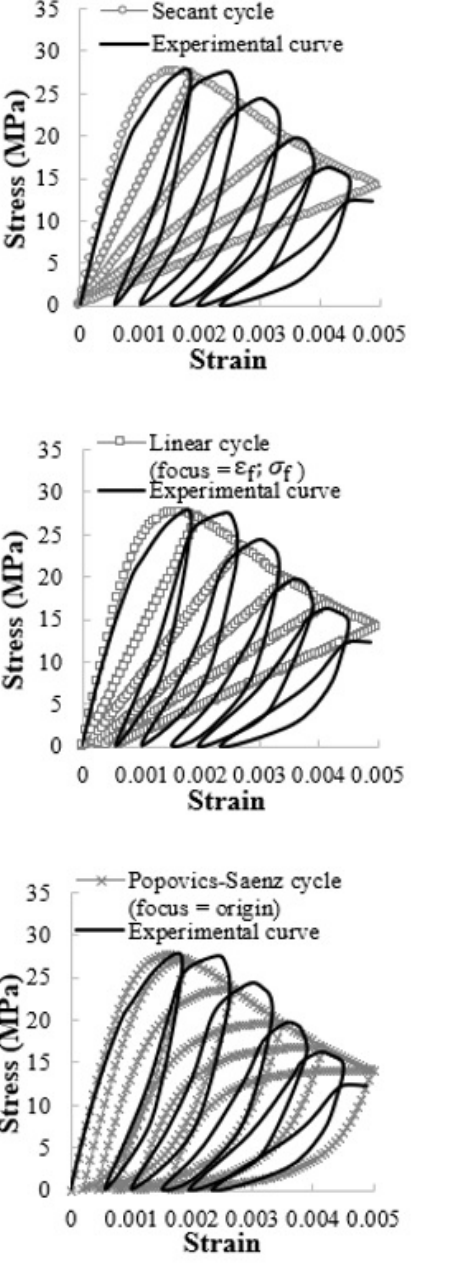
Figure 11. Direct compression simulations: different strategies to represent the load